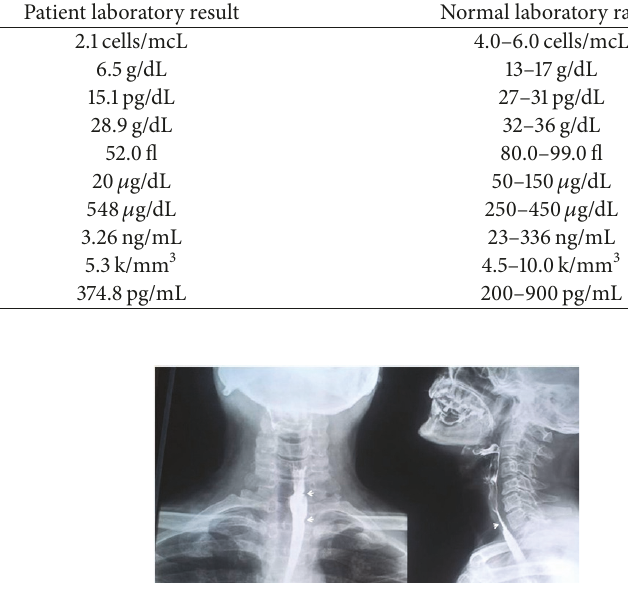
Figure 2: Barium esophagram showing the presence of Cervical- Esophageal